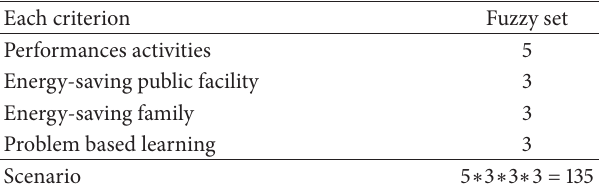
Table 2: Numbers of fuzzy sets in each criterion and total